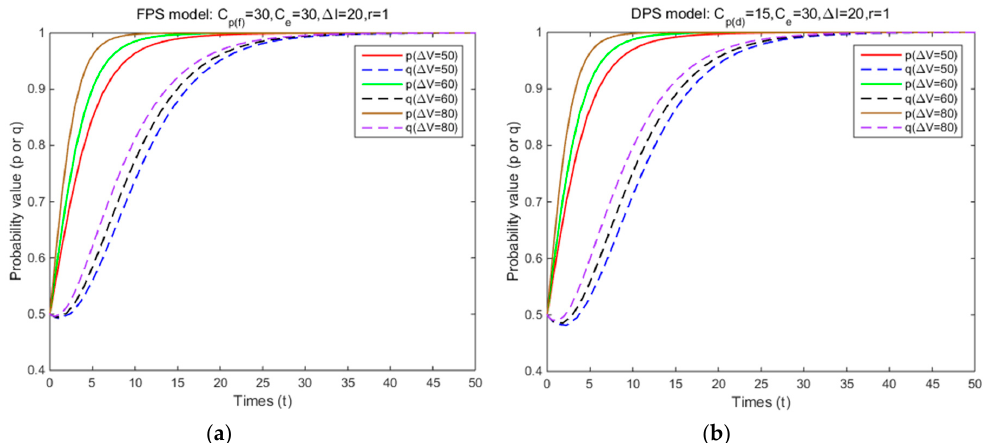
Figure A2. The effects of penalty amount on strategy probabilities of cyclists and law enforcement under FPS ( a ) and DPS ( b ) (Situation 2).